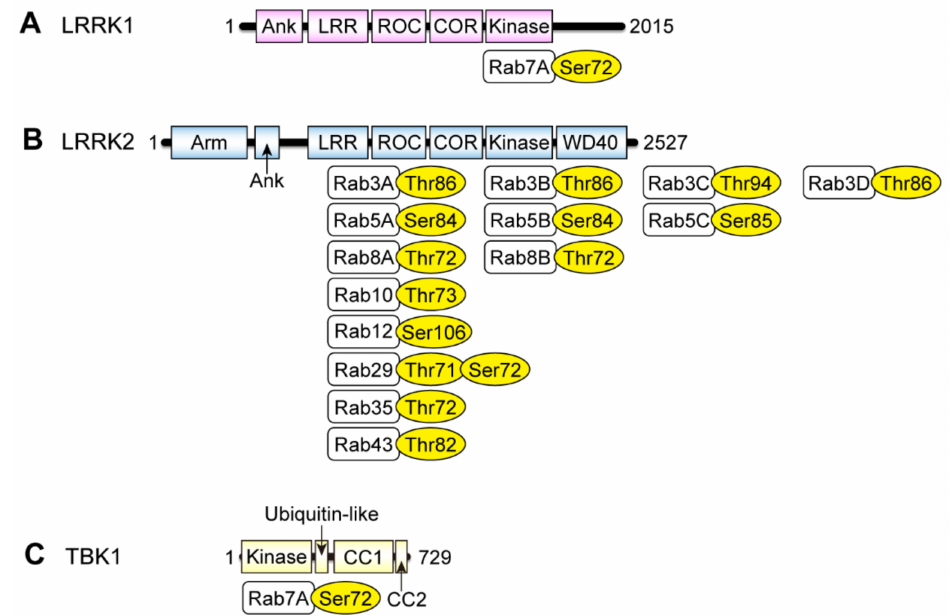
Figure 2. Domain architectures of the Rab kinases and their substrate Rab proteins. Domain architectures of ( A ) leucine-rich repeat kinase 1 (LRRK1), ( B ) leucine-rich repeat kinase 2 (LRRK2) and ( C ) TANK-binding kinase 1 (TBK1), and their substrate Rab proteins as well as the phosphorylation sites. Ank: ankyrin repeats; Arm: armadillo repeats; LRR: leucine-rich repeats; ROC: Ras of complex proteins; COR: carboxyl-terminal of ROC; WD40: WD40 repeats; CC: